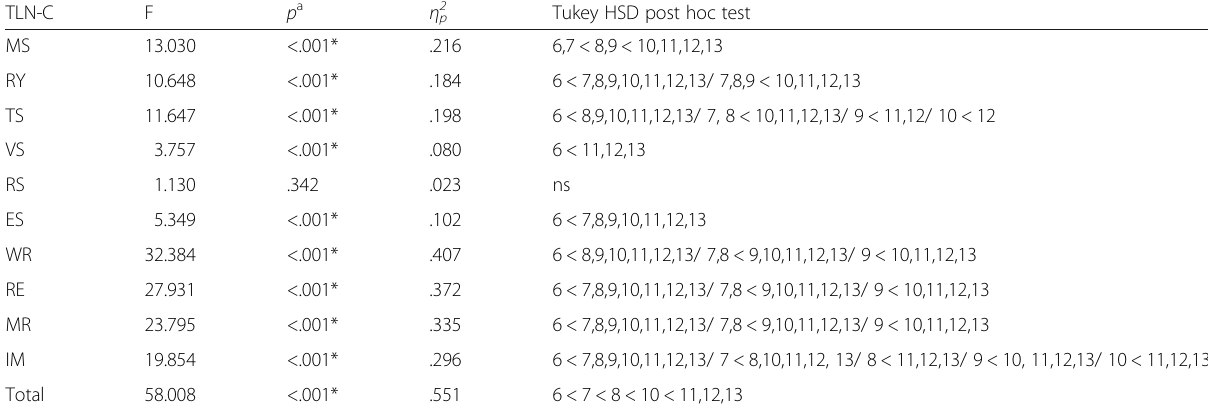
Table 3 Comparison of different ages in TLN-C subtests controlling effect of total IQ by Ancova